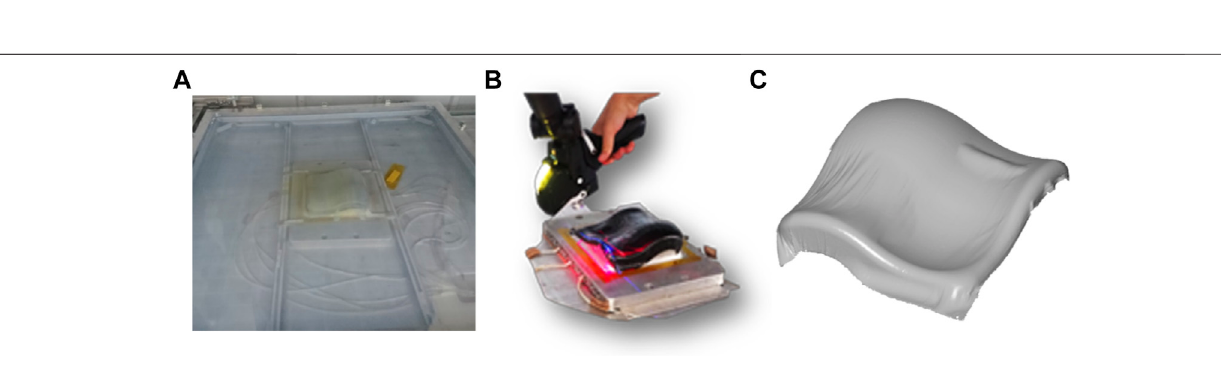
FIGURE4|(A) Experimentalsetupatthediaphragmformingmachinepriortotheformingstep, (B) schematiccross-sectionviewpriorandduringtheformingstep.